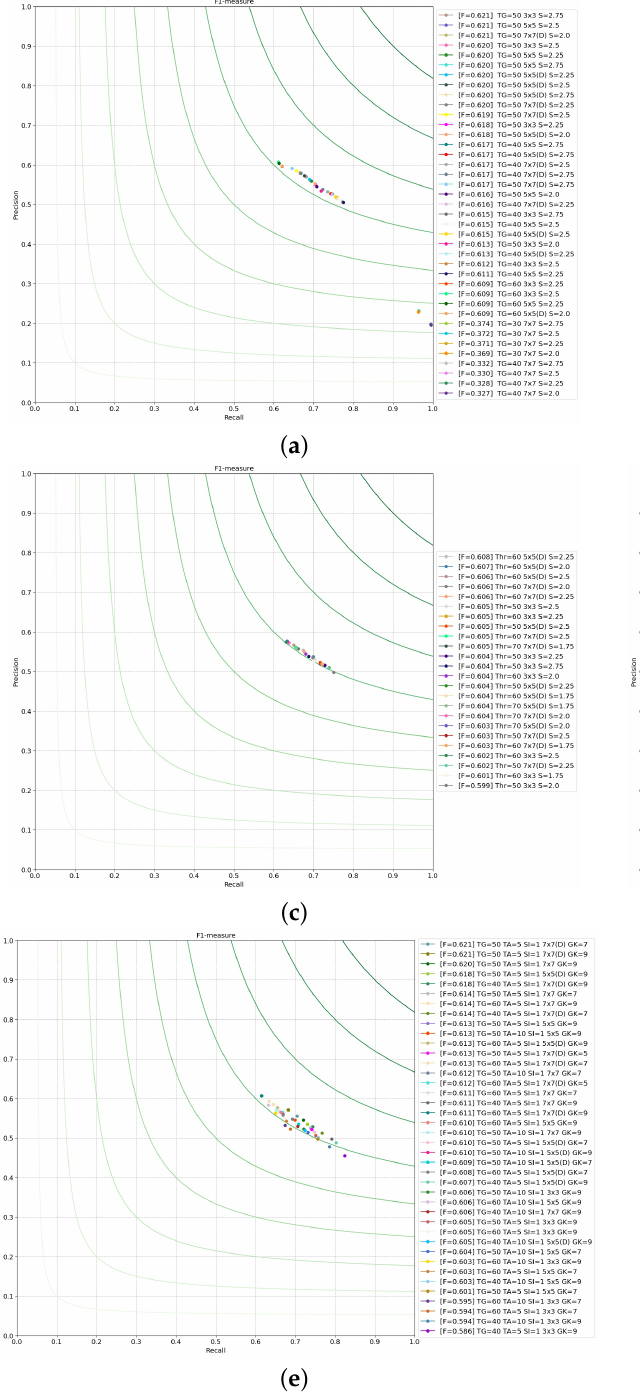
Figure 7. Best results on BSDS 500 for classic, extended and dilated using different parameters for: ( a ) first-order derivative orthogonal gradient operators; ( b ) first-order derivative compass gradient operators; ( c ) Frei–Chen edge operator; ( d ) Canny operator; ( e ) ED edge